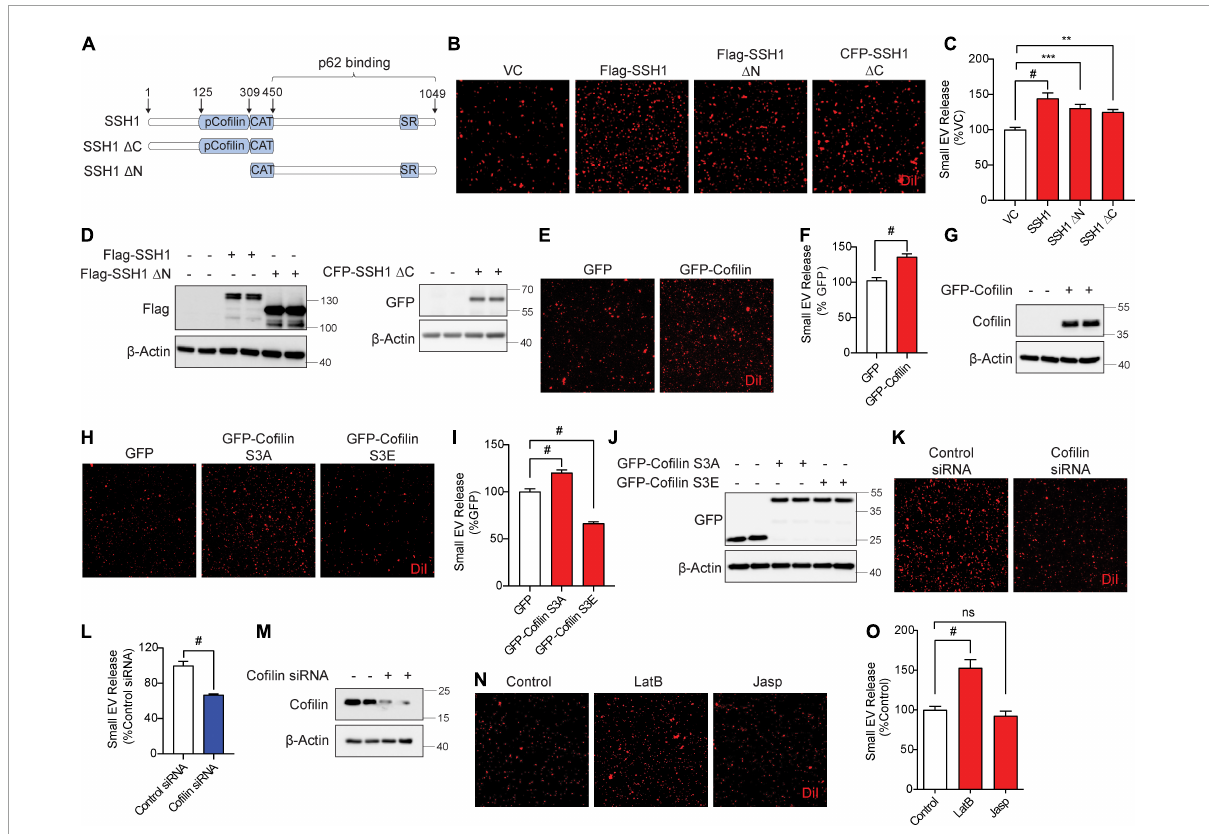
FIGURE4 Slingshot homolog-1 (SSH1) increases small EV secretion partially through cofilin activation and F-actin disruption. (A) Schematic of SSH1 full length, SSH1 (cid:49) C, and SSH1 (cid:49) N proteins. (B) Representative images of DiI-stained small EVs secreted from NIH3T3 cells expressing VC, Flag-SSH1, Flag-SSH1 (cid:49) N, or CFP-SSH1 (cid:49) C. (C) Quantification of secreted small EVs for (B) . Data are presented as means ± SEM. n = 3 independent experiments, 1-way ANOVA, followed by Dunnett’s post-hoc , # P < 0.0001, *** P = 0.001, ** P = 0.0069. (D) Representative immunoblots for Flag, GFP, and β -Actin protein levels in cell lysates for (B) . (E) Representative images of DiI-stained small EVs secreted from NIH3T3 cells expressing GFP or GFP-Cofilin. (F) Quantification of secreted small EVs for (E) . Data are presented as means ± SEM. n = 3 independent experiments, t -test, # P < 0.0001. (G) Representative immunoblots for cofilin and β -Actin protein levels in cell lysates for (E) . (H) Representative images of DiI-stained small EVs secreted from NIH3T3 cells expressing GFP, GFP-cofilin-S3A, or GFP-cofilin-S3E. (I) Quantification of secreted small EVs for (H) . Data are presented as means ± SEM. n = 3 independent experiments, 1-way ANOVA, followed by Dunnett’s post-hoc , # P < 0.0001. (J) Representative immunoblots for GFP and β -Actin protein levels in cell lysates for (H) . (K)